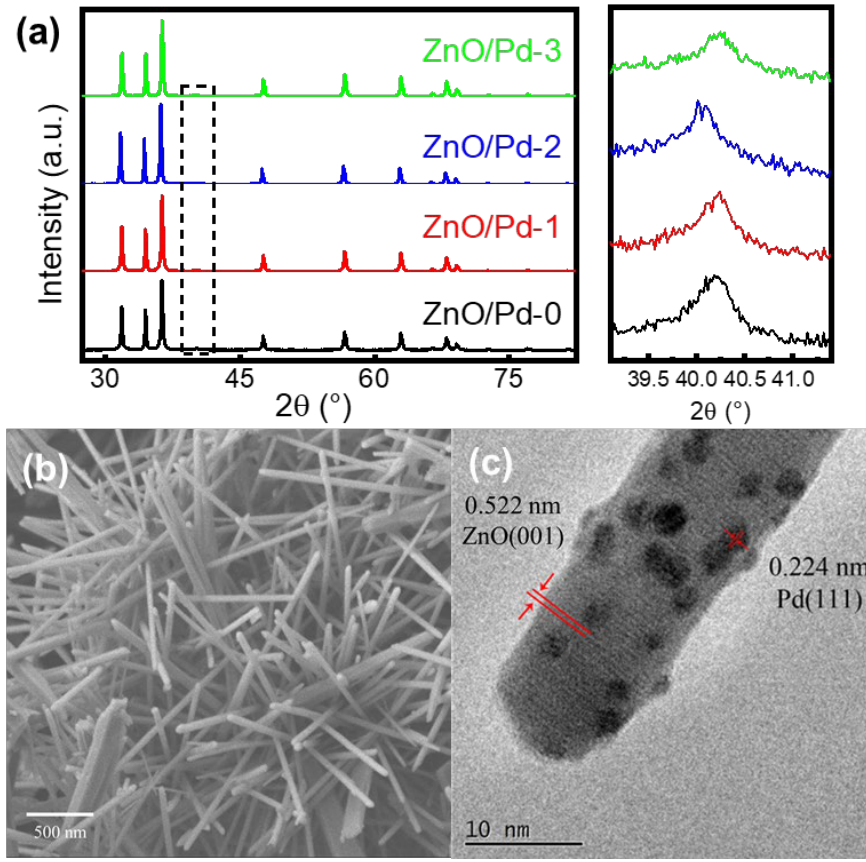
Figure 1. ( a ) XRD patterns of ZnO/Pd-0, 1, 2 and 3. ( b ) SEM and ( c ) TEM image of ZnO/Pd-2. It can be observed from Figure 2 that the average particle size of Pd NPs was 8.63, 5.78, 2.67, and 2.54 nm for ZnO/Pd-0, 1, 2, and 3, respectively, since PVP limits the growth